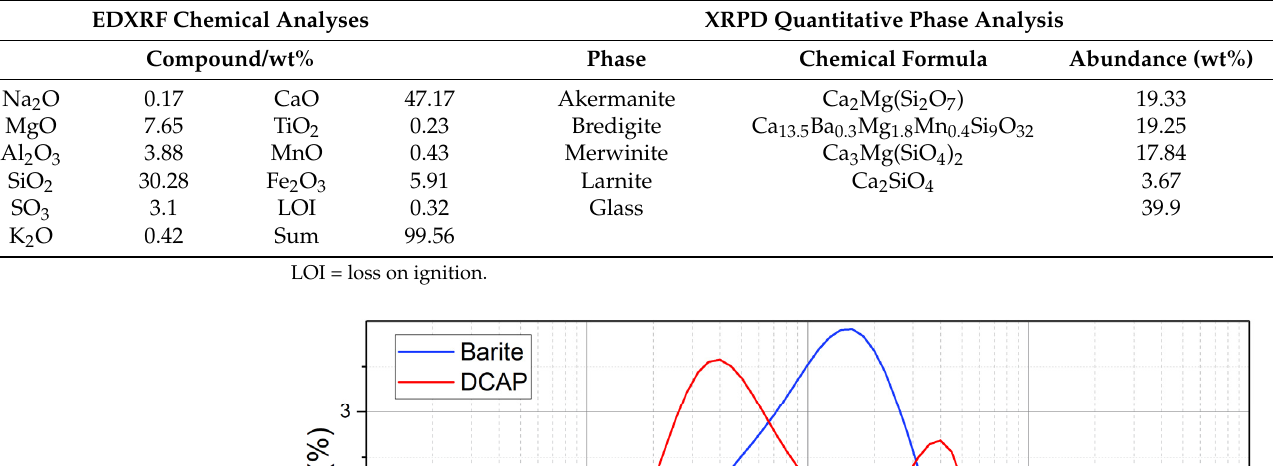
Table 2. Bulk chemical and mineralogical compositions of DCAP (from Vergani et al. 2021 [2]).